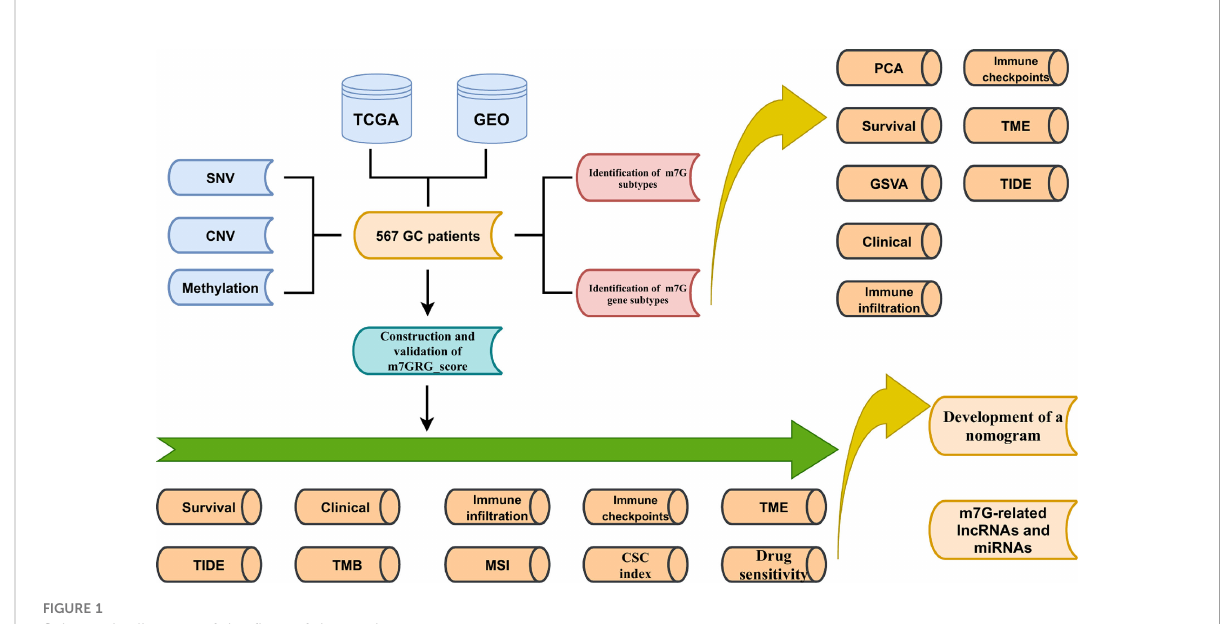
FIGURE 1 Schematic diagram of the fl ow of the